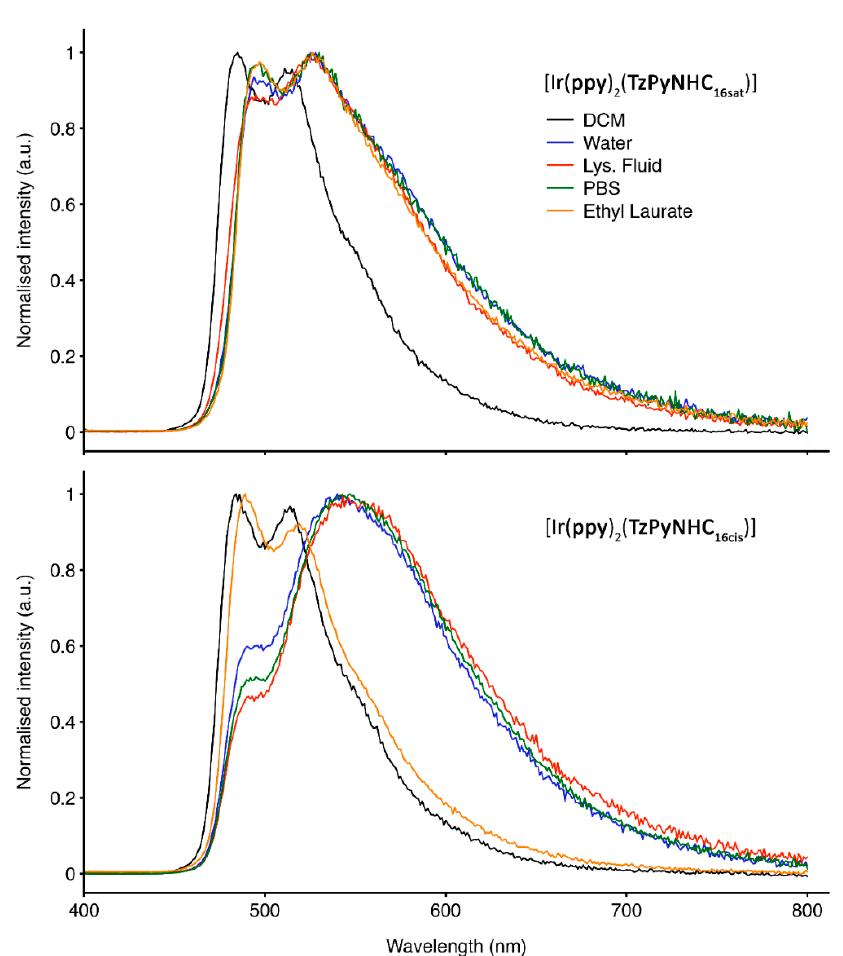
Figure 3. Emission spectra of [Ir( ppy ) 2 ( TzPyNHC 16sat )] (top) and [Ir( ppy ) 2 ( TzPyNHC 16cis )] (bottom) from diluted solutions with excitation at 350 nm.